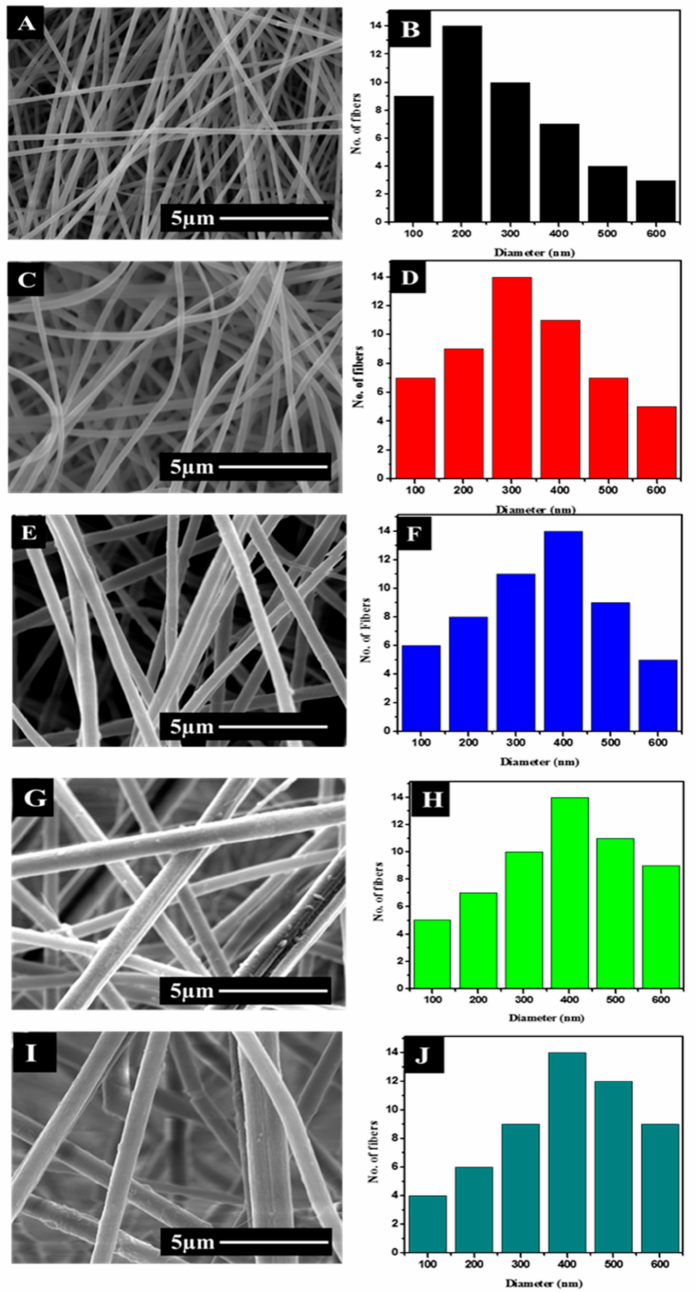
Figure 1. SEM micrographs and diameter histograms of S1 ( A , B ), S2 ( C , D ), S3 ( E , F ), S4 ( G , H ), and S5 ( I , J